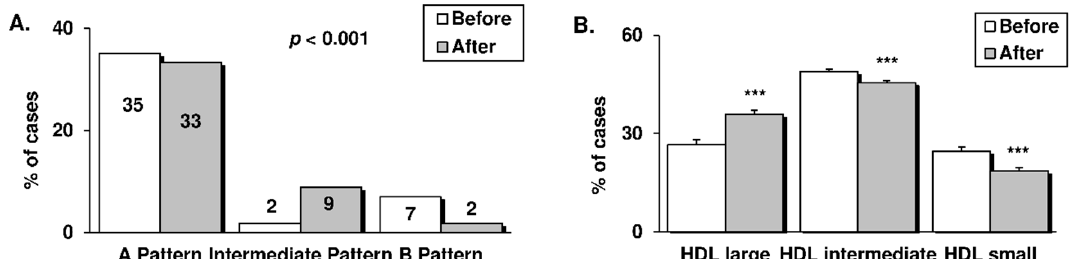
Figure 3. Cholesterol subfractions in obese patients before and 12 months after RYGB intervention, determined by the Quantimetrix Lipoprint ® system. ( A ) LDL electrophoretic profiles are expressed as the percentage of patients ( n = 25) displaying a particular LDL pattern. Patterns refer to the size of LDL particles, as follows: Pattern A (cut-off diameter ≥ 268 Å); Intermediate Pattern (cut-off diameter 264–267 Å) and Pattern B (cut-off diameter ≤ 265 Å). ( B ) HDL profile, expressed as the percentage of patients ( n = 25) displaying a particular HDL pattern: Large, intermediate, or small. Data are represented as a percentage of LDL patterns or mean + SE. *** p < 0.001 when proportions were compared using a Х 2 test or a paired Student’s t -test. RYGB: Roux-en-Y gastric bypass; LDL: Low- density lipoprotein; HDL: High-density lipoprotein.